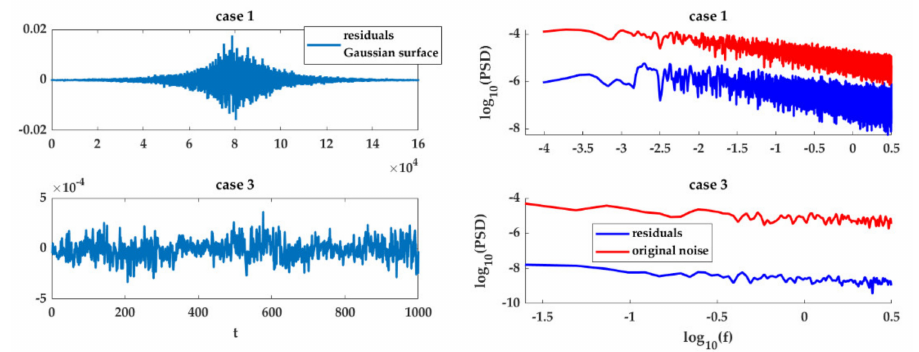
Figure 9. ( left ): Residuals of the B-spline approximation for a Gaussian surface. Case 1 ( top ); the whole residuals and case 3: the 1000 first observations corresponding to one scanning line. ( right ): The corresponding PSD (red the original noise, blue the